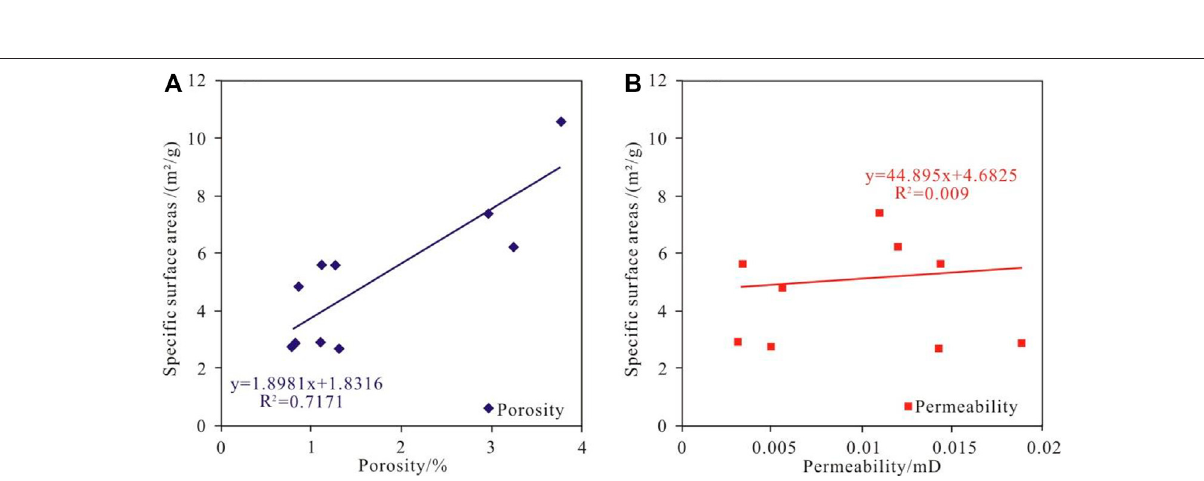
FIGURE 16 | Correlation of SSA with quartz, clay minerals and other types of clay minerals. Correlation of SSA with (A) quartz and clay minerals, (B) Illite, chlorite, mixed-layer illite-smectite (I/S). Illite (It); Chlorite (C) ; Mixed-layer illite-smectite (I/S).